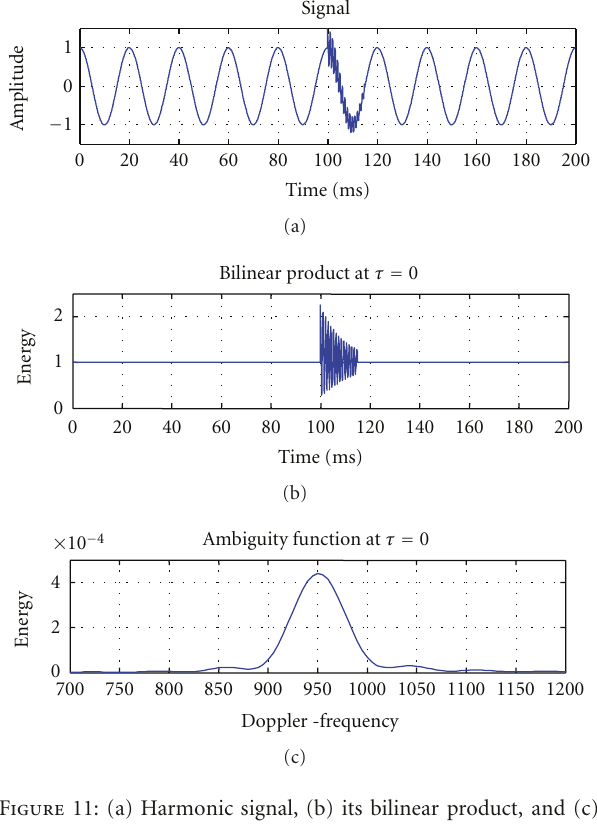
Figure 11: (a) Harmonic signal, (b) its bilinear product, and (c) ambiguity function at τ = 0.